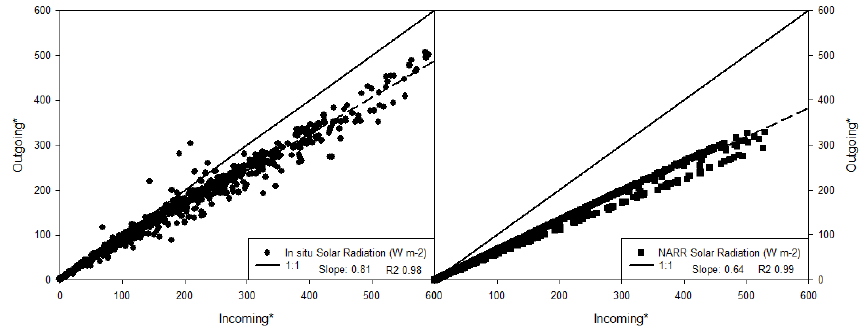
Figure 5. 2010 in situ (left) and NARR (right) incoming and outgoing shortwave radiation. NARR data from 2010 resulted in an unrepre- sentative albedo (slope) of 0.64 compared with 2010 in situ measurements (0.81; proxy comparison denoted by ∗ ).